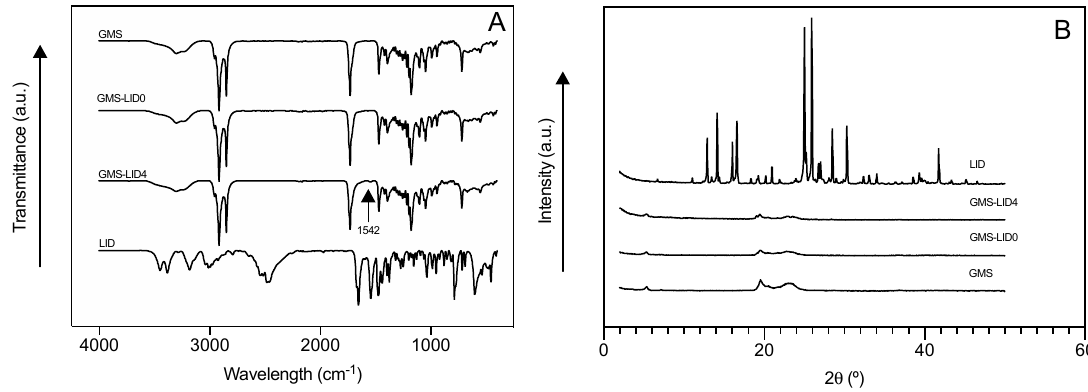
Figure 3. ( A ) Attenuated Total Reflectance/Fourier-Transform Infrared Spectroscopy (ATR/FT-IR) spectra and ( B ) X-ray diffraction (XRD) patterns of pure GMS, solid lipid microparticles (SLMPs) of GMS processed by the Particles from Gas-Saturated Solutions (PGSS) technique (GMS-LID0), SLMPs loaded with LID (GMS-LID4), and pure LID powder.